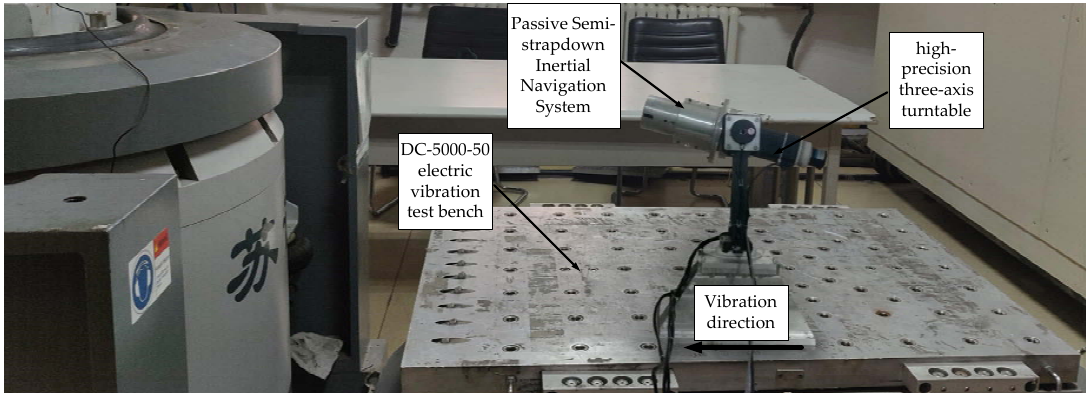
Figure 13. The projectile’s high ‐ rotation and acceleration environment simulation experiment.